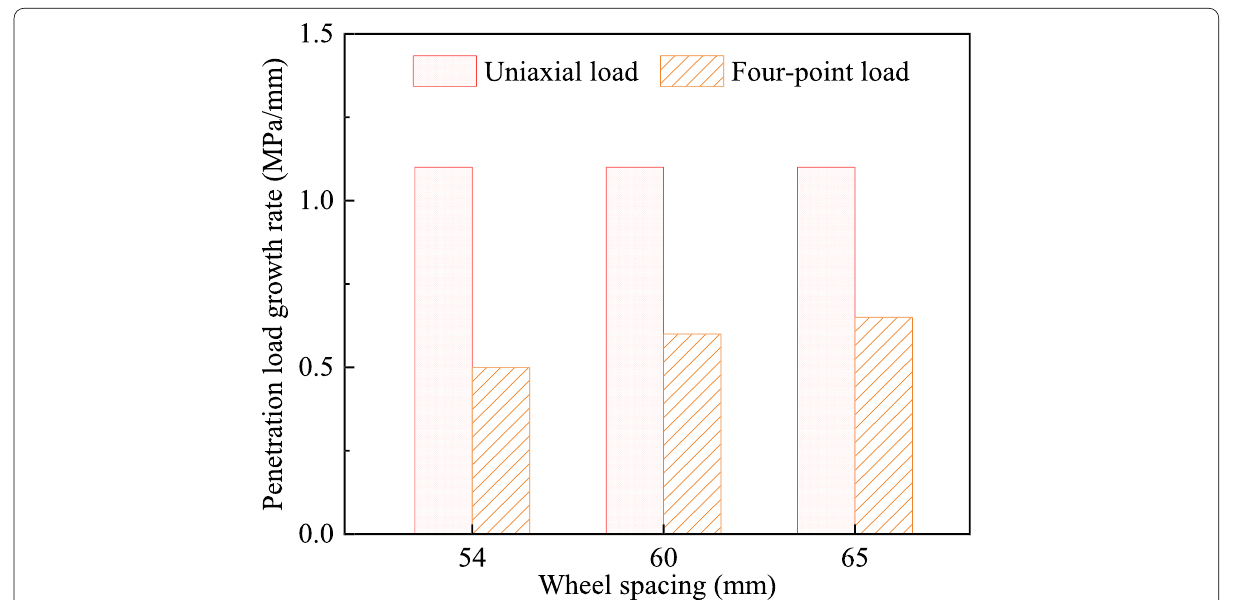
Fig. 9 Penetration load growth rate with different wheel